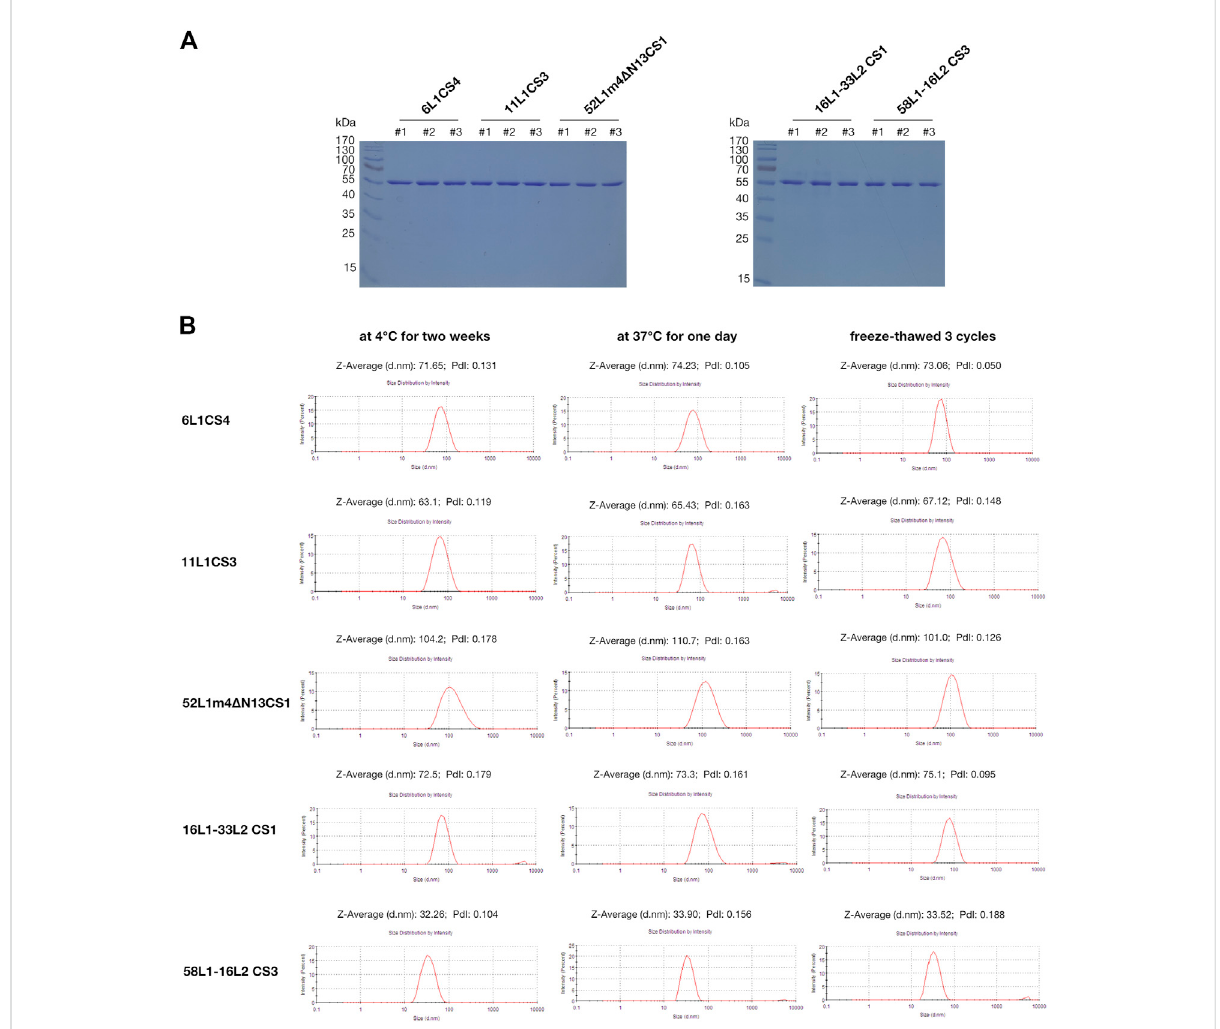
Analysisoftheproteinstabilitiesof6L1CS4,11L1CS3,52L1m4 Δ N13CS1,16L1-33L2CS1,and58L1-16L2CS3storedat4 ° Cfor2 weeks,at37 ° Cfor 1 day, or underwent three freeze-thaw cycles. (A) The protein degradation was analyzed by SDS-PAGE, and each lane was loaded with 5 μ g